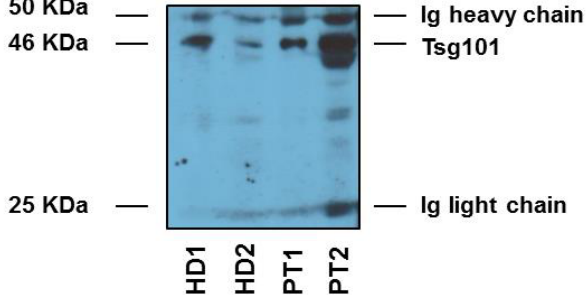
Figure 1. Protein quantification and characterization by Western blot analysis for housekeeping markers of exosomes. Western blot analyses of tumour susceptibility gene 101 (Tsg101). HD1 and 2 are healthy donors; PT 1 and 2 are two patients.